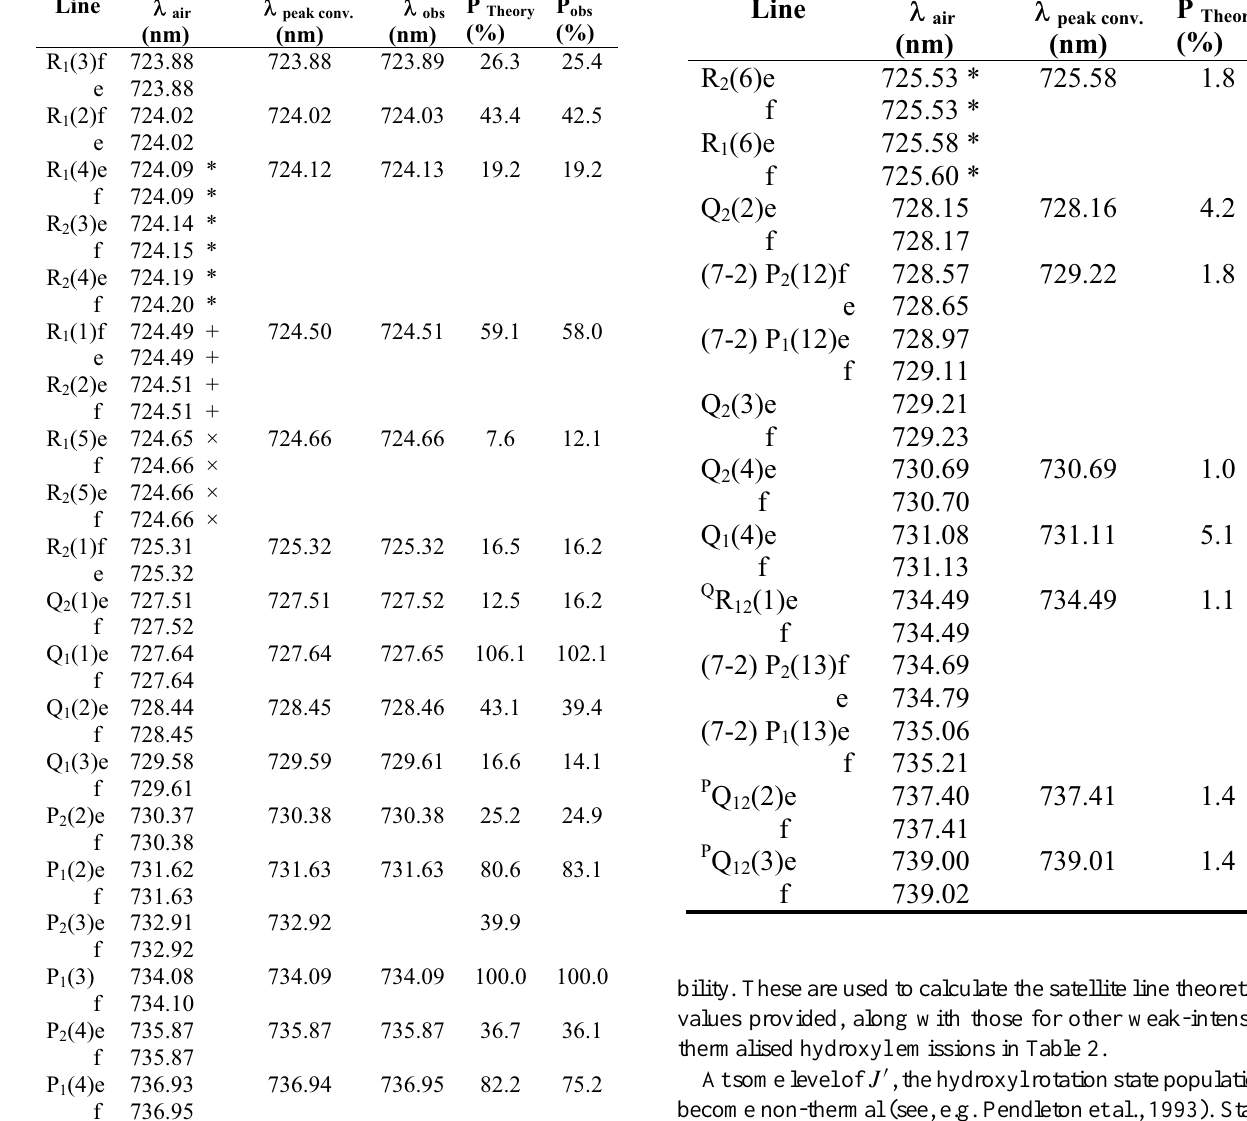
Table 1. The main OH(8–3) branch lines. A theoretical spectrum (LWR, 214K) has been convolved with the instrument function and the peak wavelength ( λ peakconv . ) and peak intensity ( P theory ) rela- tive to the P 1 (3) emission is listed and compared with measurements from Fig. 1 ( λ obs and P obs ). Blended lines are indicated by symbols ( ∗ , +, x).